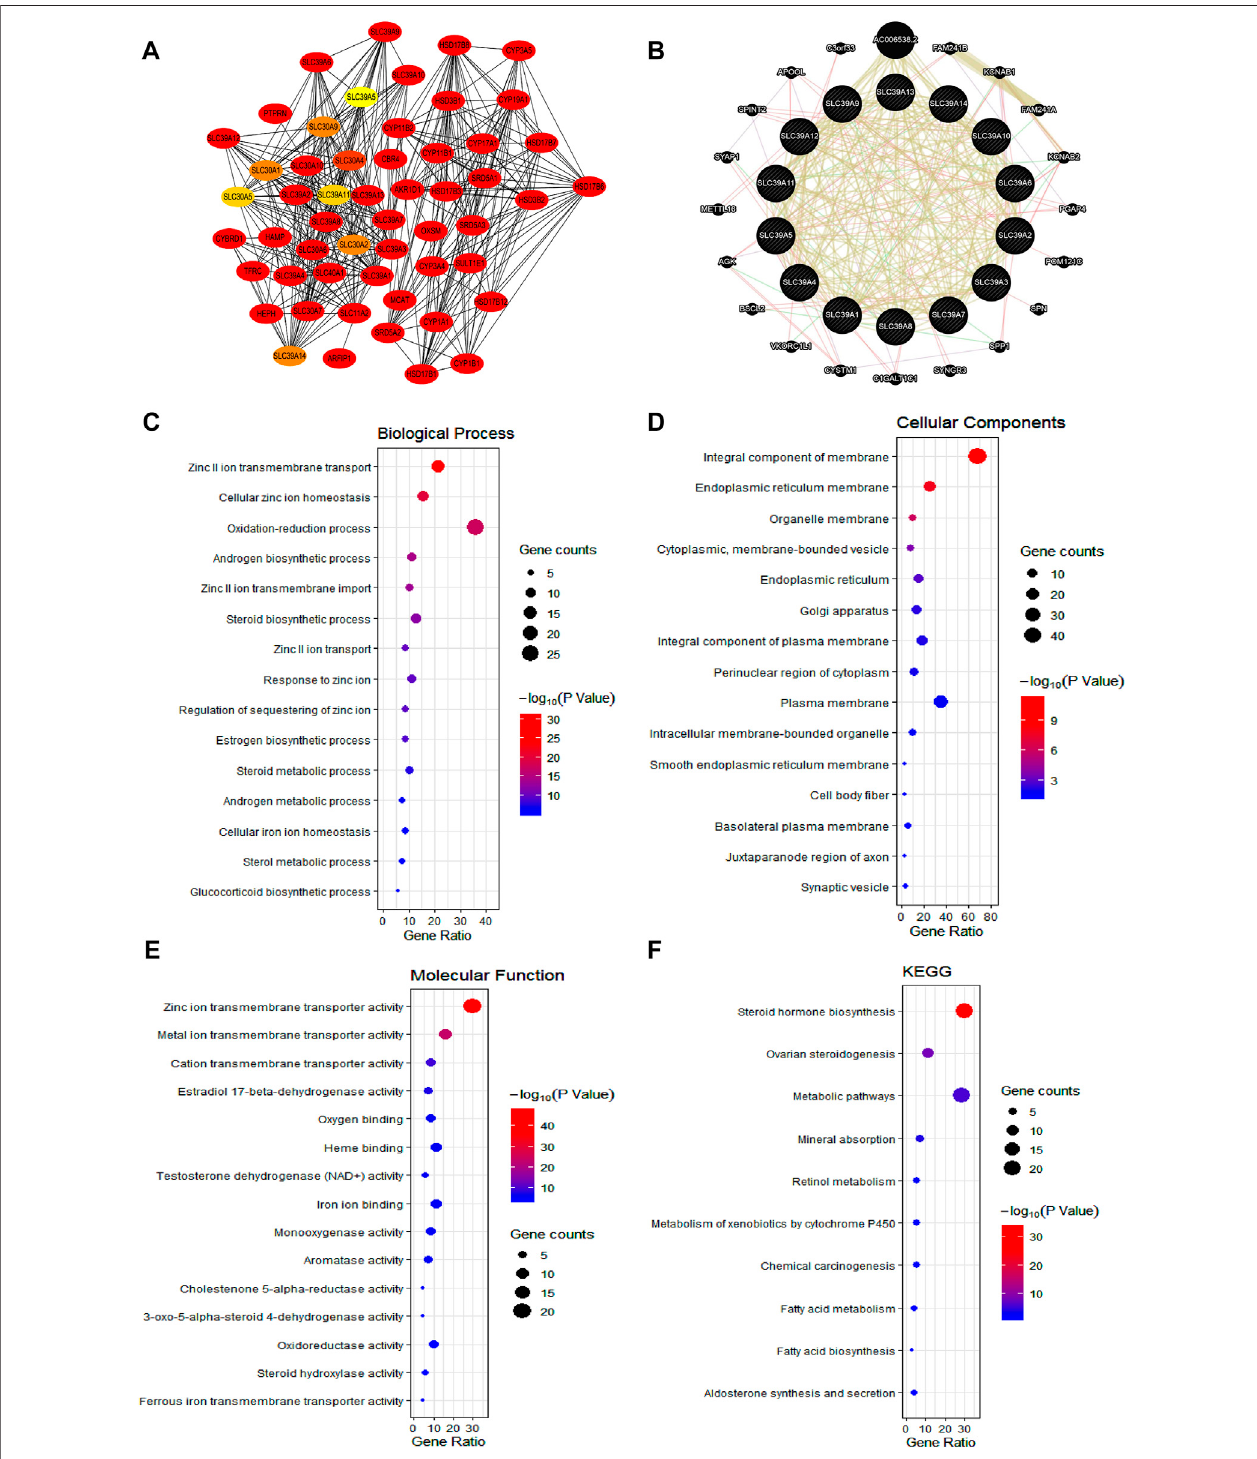
FIGURE 6 | Function enrichment of the SLC39A family genes in pan-cancer. (A) Protein – protein interaction of SLC39A family in the STRING dataset. (B) Gene – geneinteractionnetworkamong SLC39A familymembersintheGeneMANIAdataset. (C) BubblechartshowingtheBPof SLC39A familyhighlycorrelatedgenes. (D) BubblechartshowingtheCCof SLC39A familyhighlycorrelatedgenes. (E) BubblechartshowingtheMFof SLC39A familyhighlycorrelatedgenes. (H) Bubblechart showing the KEGG of SLC39A family highly correlated genes.